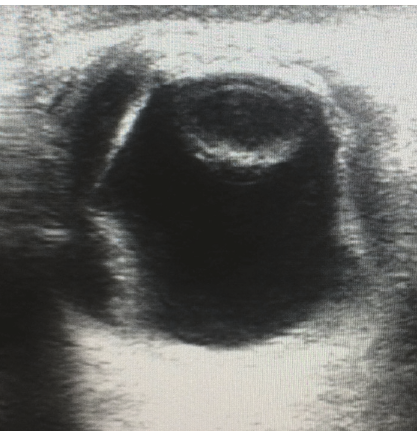
Figure 1: USG B-scan showing choroidal detachment with moder- ate intensity echoes in suprachoroidal